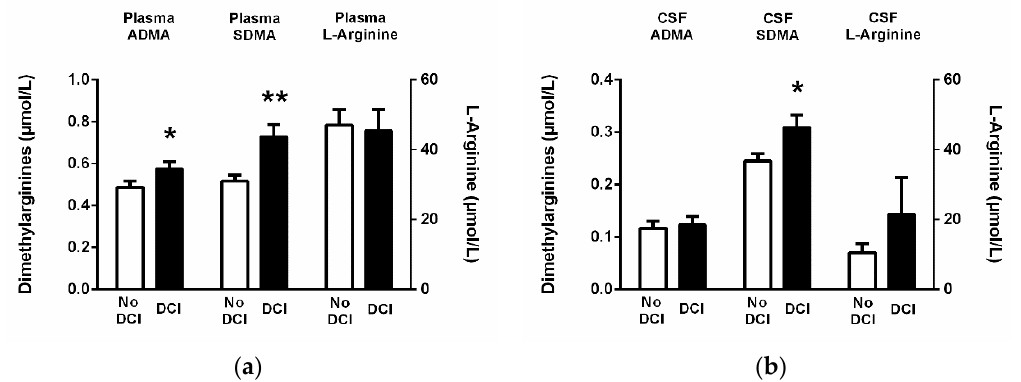
Figure 2. Concentrations of ADMA, SDMA, and L-arginine in ( a ) plasma and ( b ) CSF at the time of admission. A total of 51 patients with SAH were categorized into those who developed delayed cerebral ischemia (N = 18) or not (N = 33). Data are mean ± S.E.M. * p < 0.05, ** p < 0.01 vs. no DCI group. Abbreviations: ADMA, asymmetric dimethylarginine; CSF, cerebrospinal fluid; DCI, delayed cerebral ischemia; SDMA, symmetric dimethylarginine; S.E.M., standard error of the mean